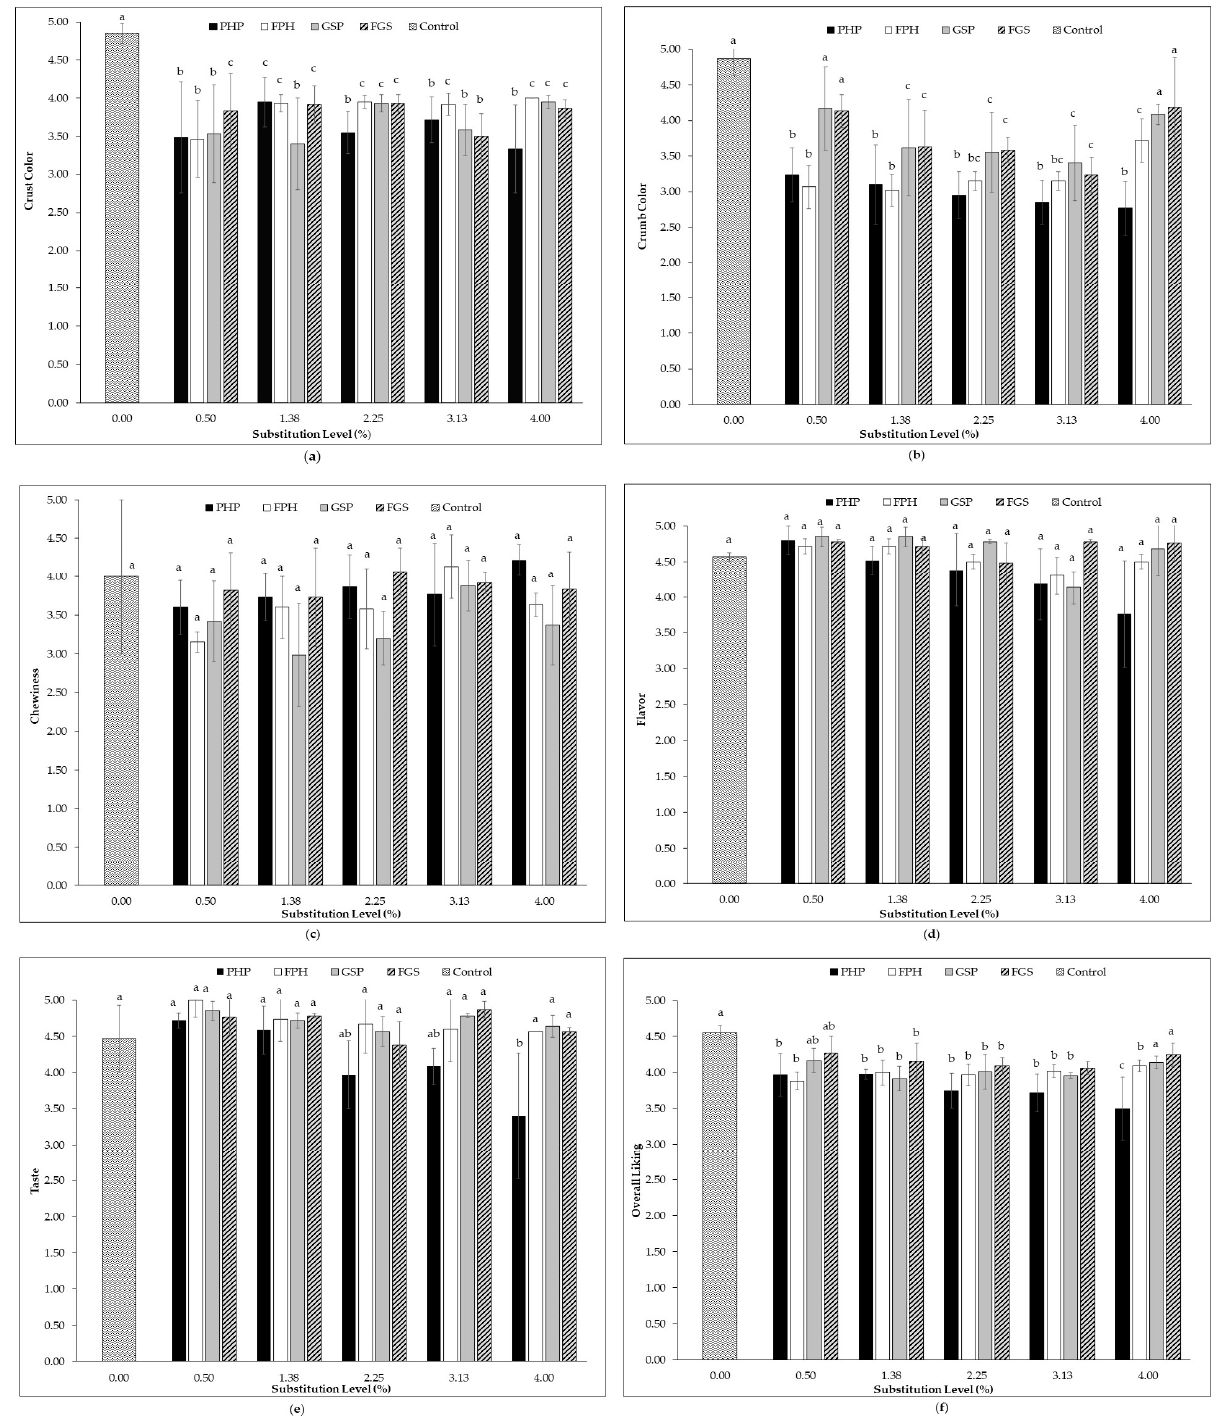
Figure 5. Results of the sensory analysis of the control and enriched breads. Crust color ( a ), crumb color ( b ), chewiness ( c ), flavor ( d ), taste ( e ), and overall liking ( f ). Values of each parameter with the same letters were not significantly different ( p >